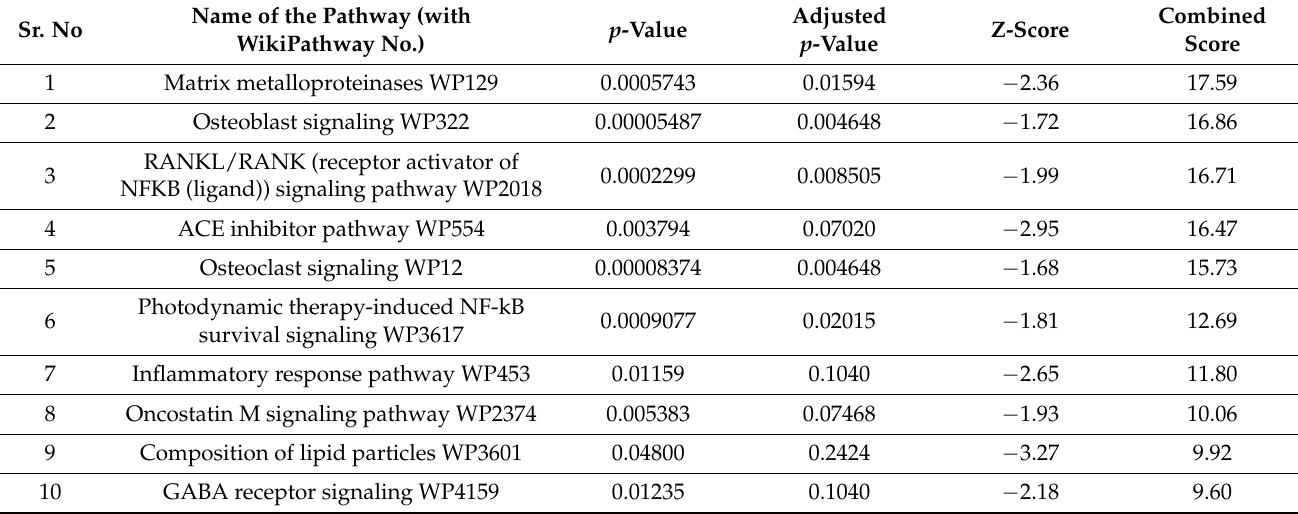
Table 1. Key pathways with their p -values, Z-score and combined score, generated during function analysis of the differentially expressed genes in osteophyte samples.